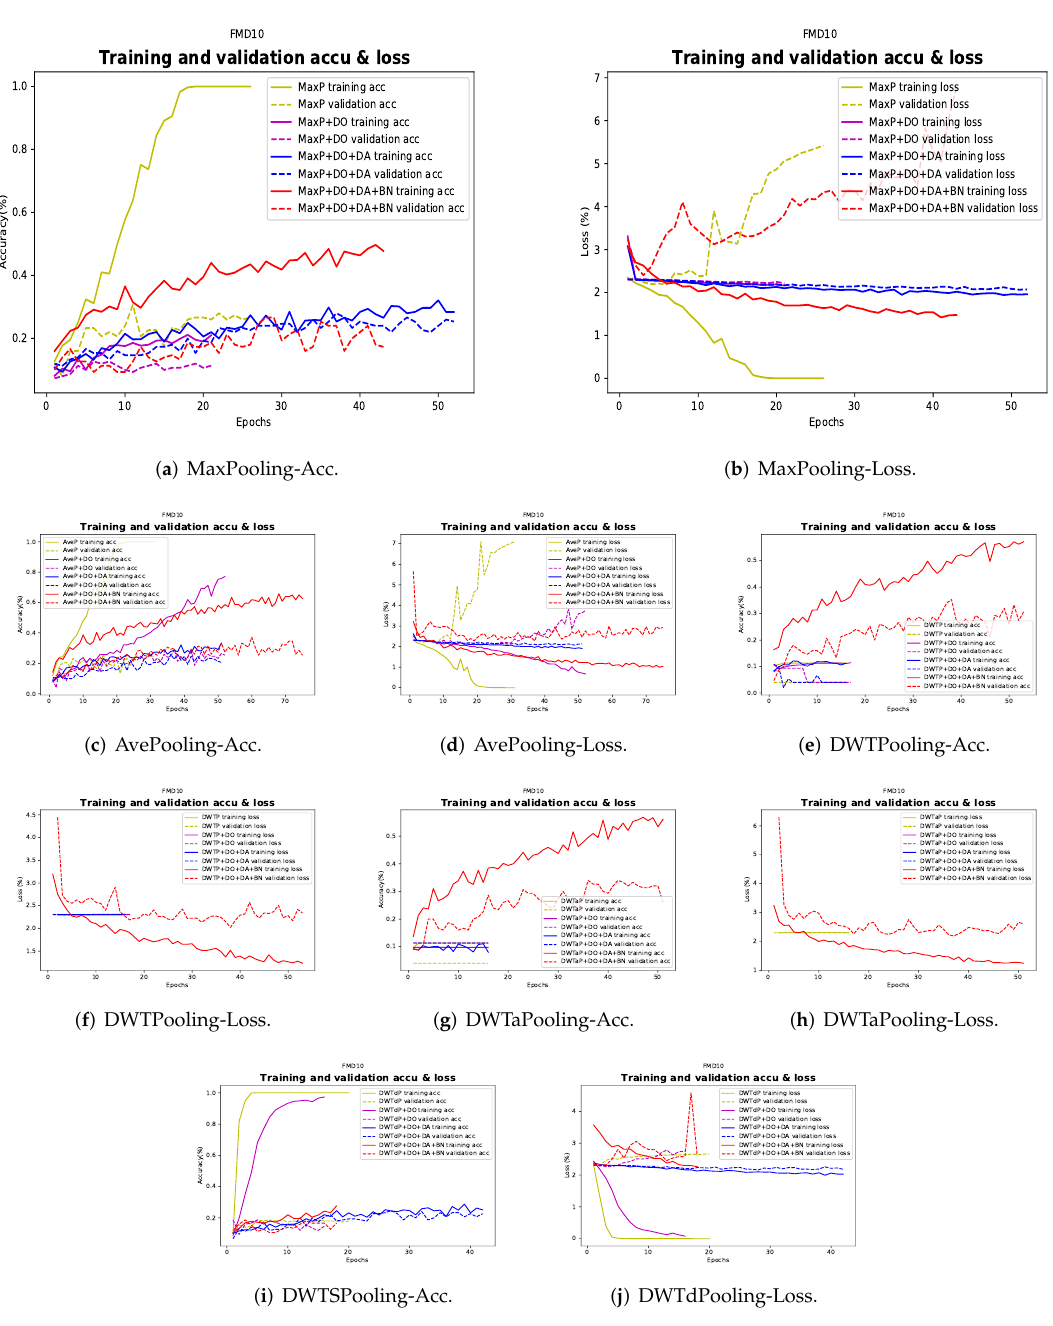
Figure A2. Learning behavior for baseline architecture + pooling, increasing DropOut, Data Aug- mentation, and Batch Normalization—FMD